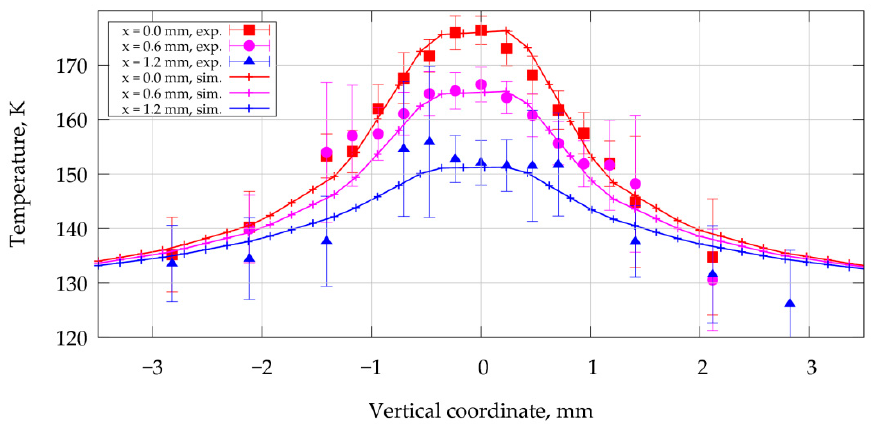
Figure 6. Horizontal cross-section distributions of equivalent temperature. “exp.” denotes experi- mental data, “sim.”—simulated data. The average absorbed pump power is estimated to 105 ± 3 W.